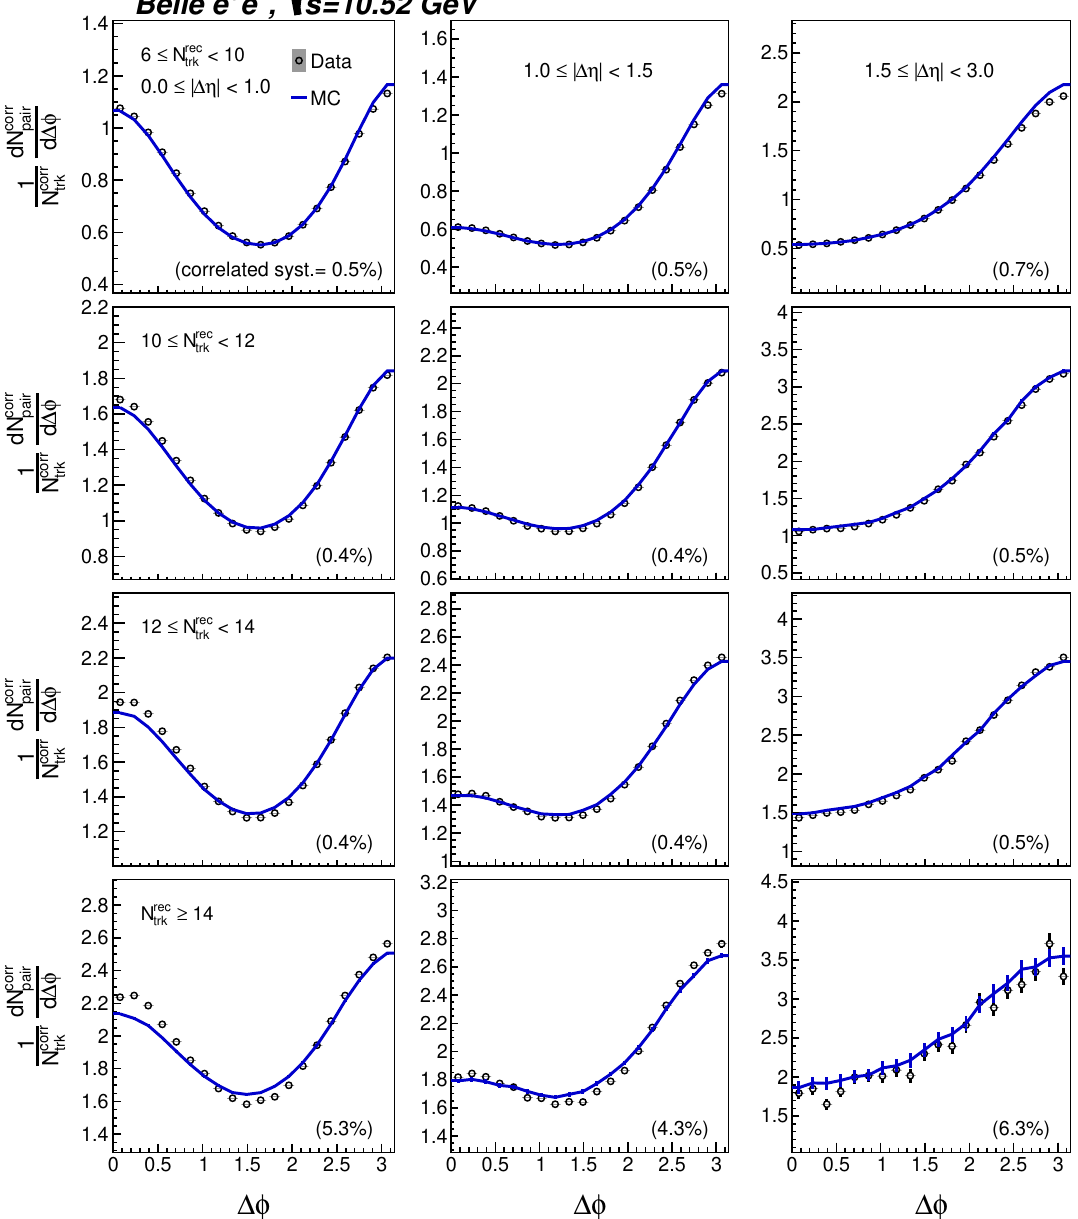
Figure 4. Beam-axis azimuthal differential associated yields as a function of the reconstructed- track multiplicity N rec for the off-resonance sample in the short-range ( 0 ≤ | ∆ η | < 1 ), middle-range trk ( 1 ≤ | ∆ η | < 1 . 5 ) and long-range ( 1 . 5 ≤ | ∆ η | < 3 . 0 ) regions in columns from left to right, respectively.